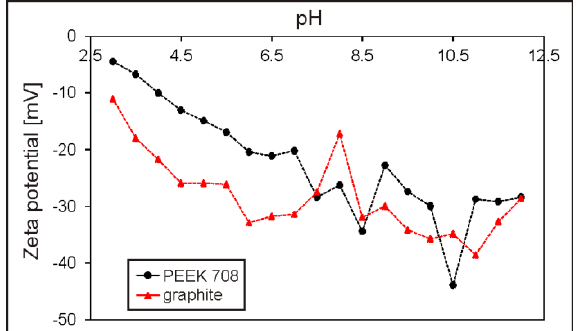
Figure 3. Zeta potential as a function of pH for graphite in ethanol and polyetheretherketone (PEEK) 708 in ethanol.